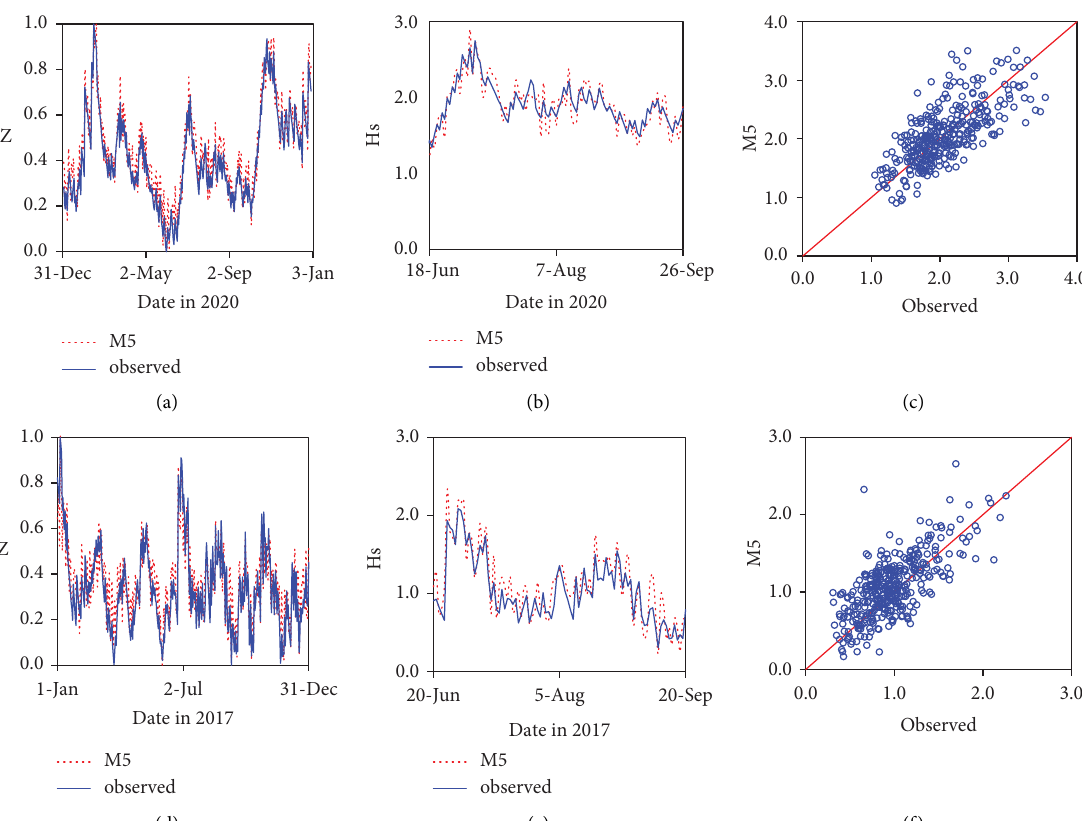
Figure 7: Times series of test and train normalized signifcant wave height and the corresponding scatter diagram by the M5MTmodel (a–c) in the Hambantota Port (2020) and (d–f) in the Sanmen Bay